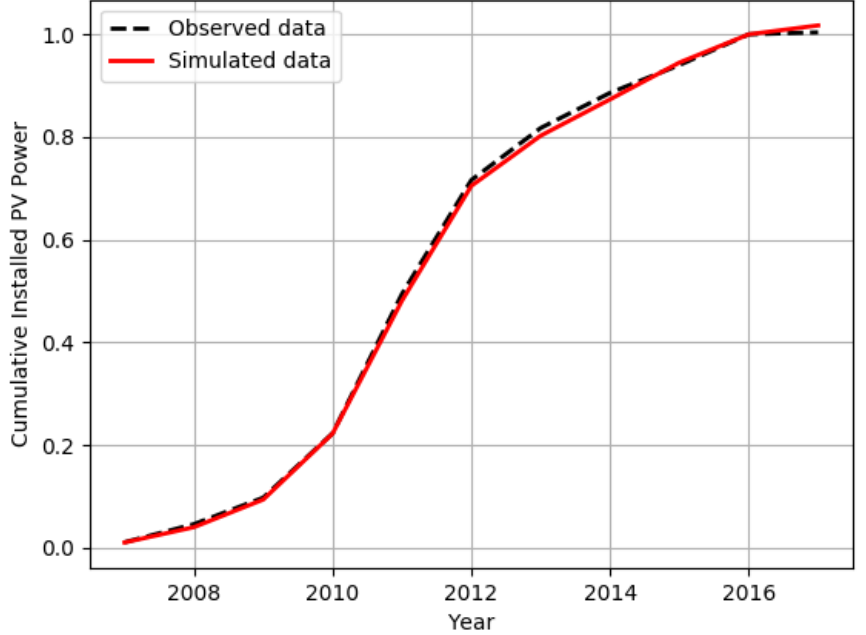
Figure 3. Model calibration results—normalized cumulative installed PV